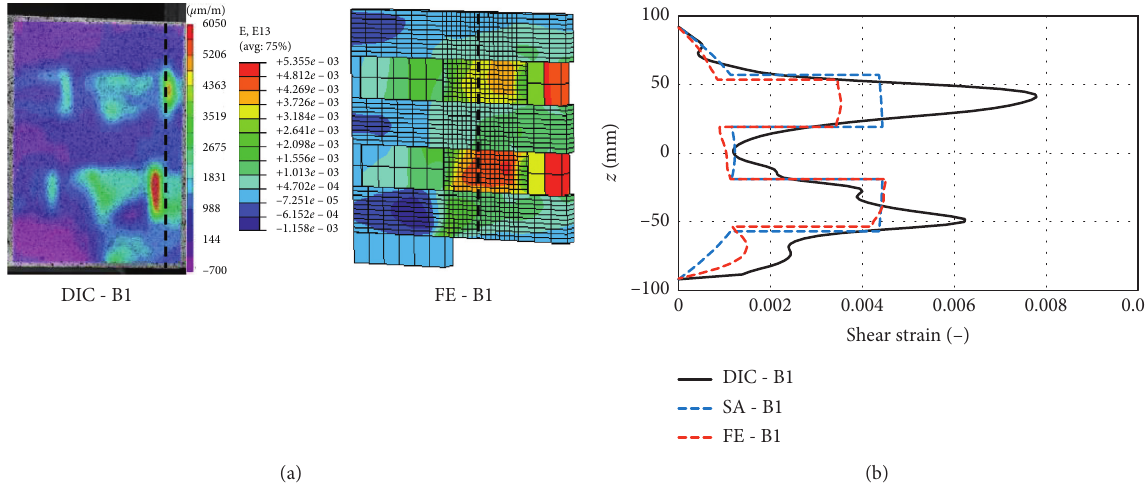
Figure 6: Colour contour plots and shear strain distribution from shear tests for B1.